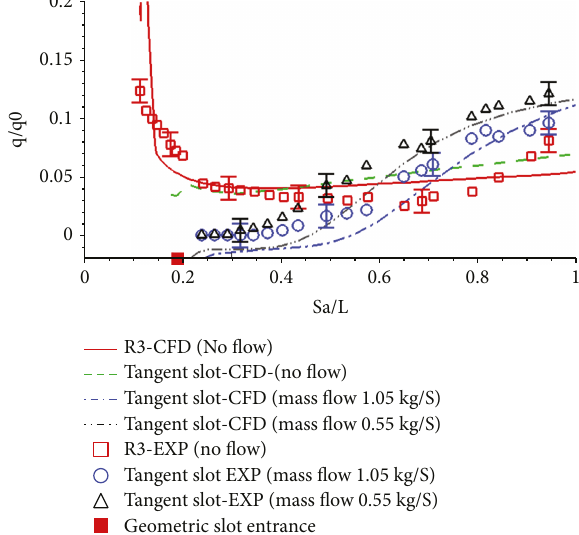
Figure 25: Pressure distribution on the tangent-slot model and the baseline model, Re = 4 3 × 10 6 , α = 0 0 ° , M = 6 8 .